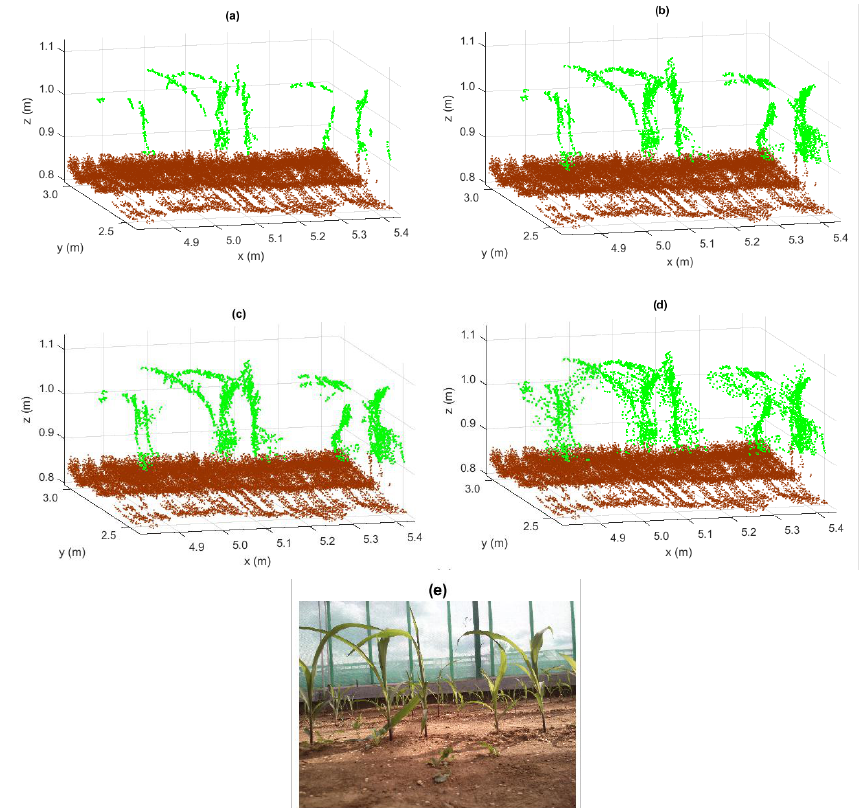
Figure 11. Detail of the aerial point cloud provided during the data fusion process at path 1 and row 2. ( a ) Vertical Go; ( b ) Vertical Go + Return; ( c ) Vertical + Inclined Go; ( d ) Vertical + Inclined; and ( e ) actual plants.